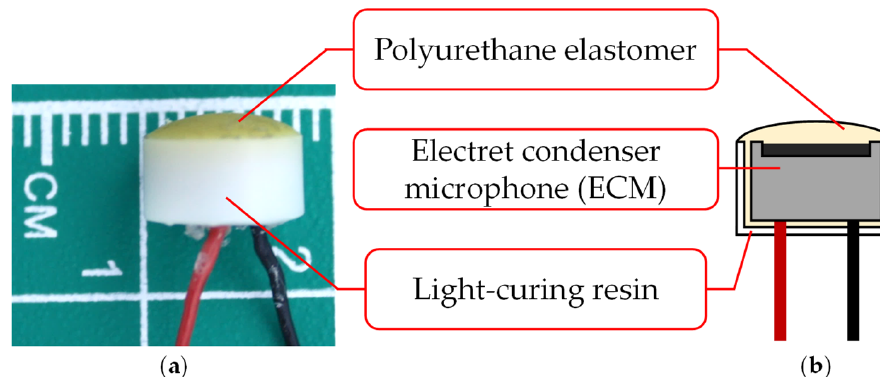
Figure 2. Sensor unit: ( a ) photograph; ( b ) cross section.